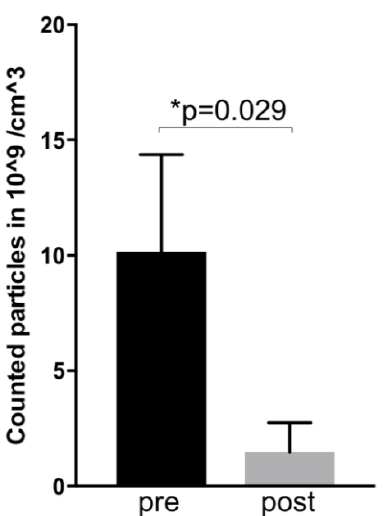
Figure 2. Preliminary results: Mean exosomal levels in blood of three patients with active HNSCC before (pre—week 0) and after (post—week 7) primary radio-chemotherapy. The exosomes were isolated as described before [11]. Measurements were performed by Zetaviewer (Particle Metrix, Duesseldorf, Germany). Statistical significance was calculated by a Student t -test.